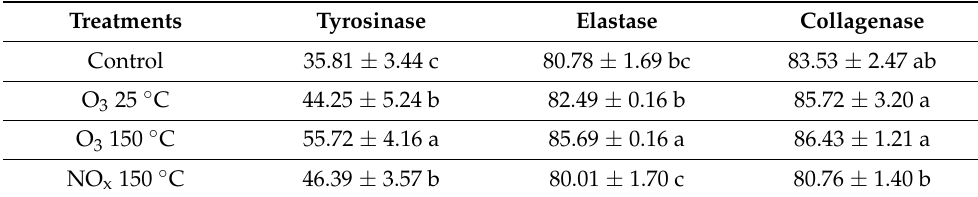
Figure 4. Normalized response of the functional compounds and physiological activities of peanut shells according to the atmospheric-pressure plasma treatment. Table 3. Skin aging-related enzyme inhibitory effect (%) in atmospheric-pressure plasma-treated peanut